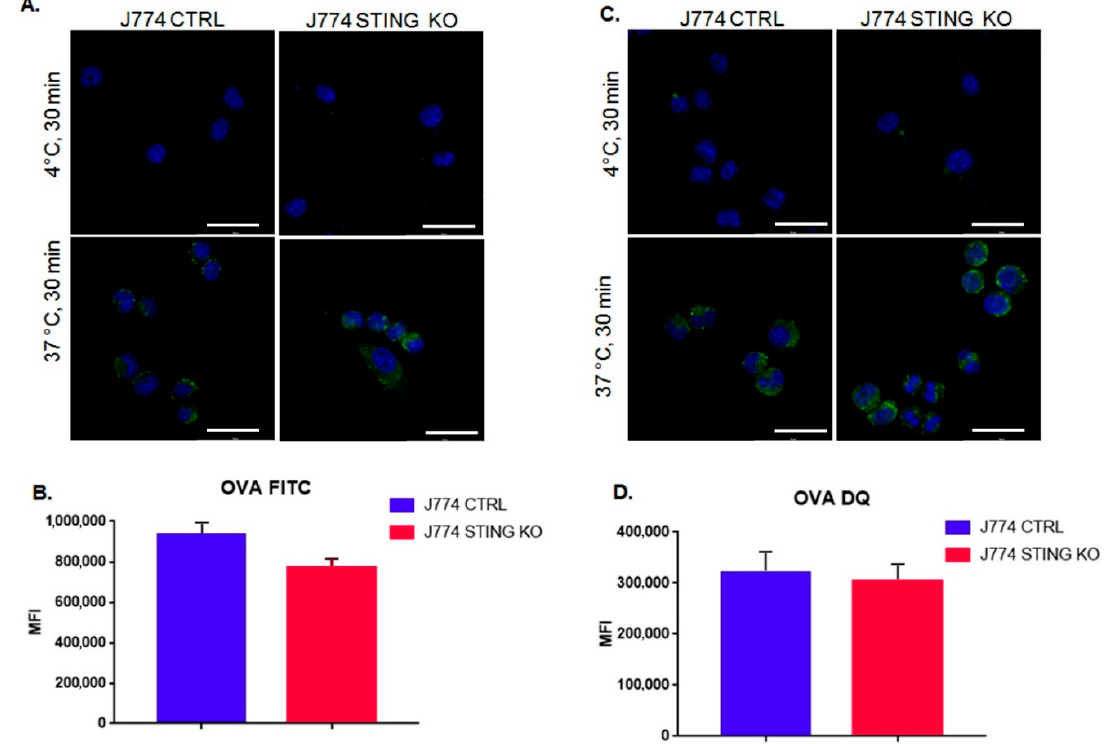
Figure 2. STING KO does not affect uptake and proteolysis of ovalbumin in murine macrophages. ( A ) J774 CTRL and J774 STING KO cells (2 × 10 5 ) were incubated in serum-free medium with 50 µ g/mL of Alexa 488-conjugated ovalbumin for 30 min at 37 ◦ C or on ice as a negative control. Nuclei were stained with DAPI. Original magnification 20x and white scale bars represent the length of 5 µ m. ( B ) Mean fluorescence intensity (MFI) of Alexa 488-conjugated OVA was analyzed by cytofluorimeter. Values (mean ± SE, n = 3) are shown. ( C ) J774 CTRL and STING KO (2 × 10 5 ) were pulsed in serum-free medium with 50 µ g/mL of DQ-ovalbumin for 3 min and chased for 30 min at 37 ◦ C. Continuous incubation on ice was performed as a negative control. Nuclei were stained with DAPI. The original magnification is 20 × and white scale bars represent a length of 5 µ m. ( D ) Mean fluorescence intensity (MFI) of DQ-OVA signal was measured with a cytofluorimeter. Values (mean ± SE, n = 3) are